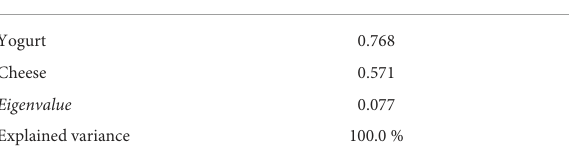
TABLE 3 Standardized coefficients of variables with discriminatory power (yogurt and aged cheese).